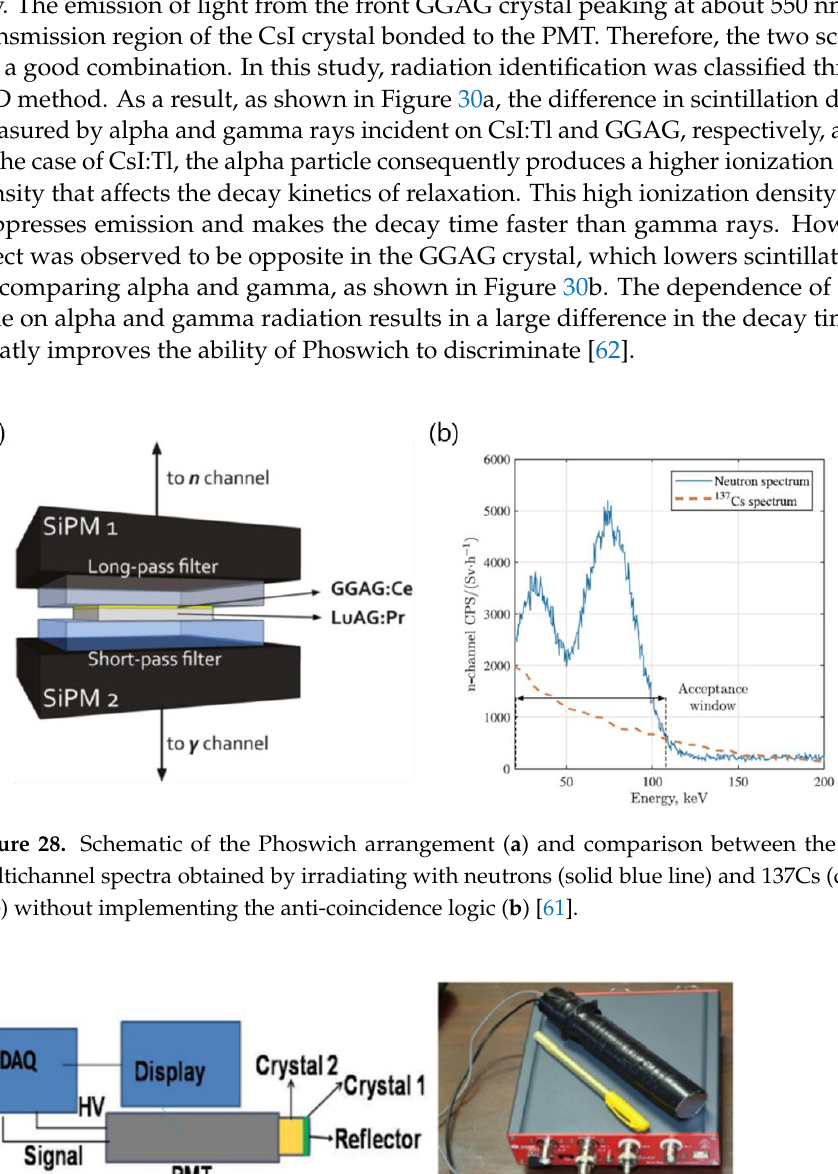
Figure 30. Scintillation decay curves measured with alpha and gamma irradiations on the CsI:Tl and the GGAG single crystal ( a ), and the GGAG/CsI:Tl Phoswich detector ( b )